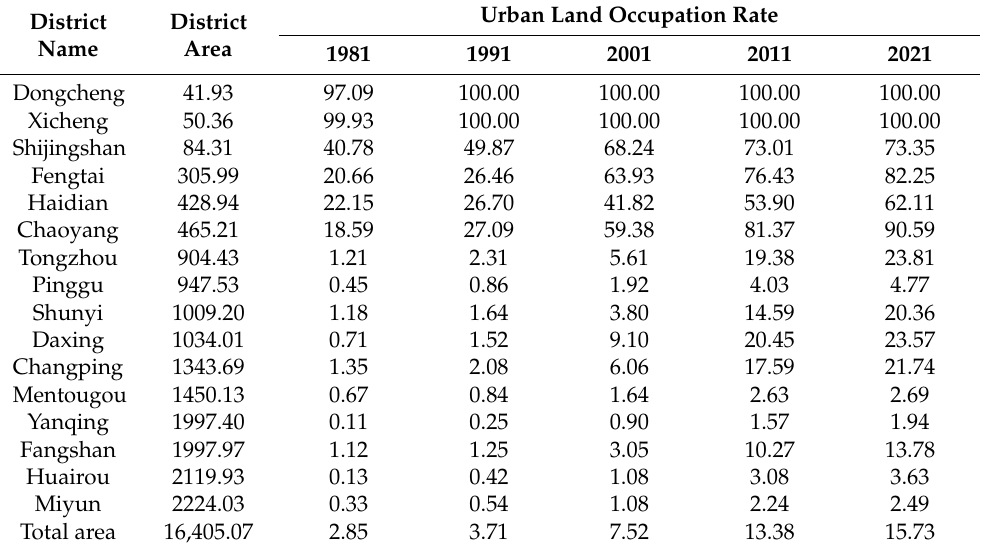
Table 4. The statistics of urban land occupation rate at the district level in different time stages from 1981 to 2021 in the study area (Area unit: km 2 , Rate unit: